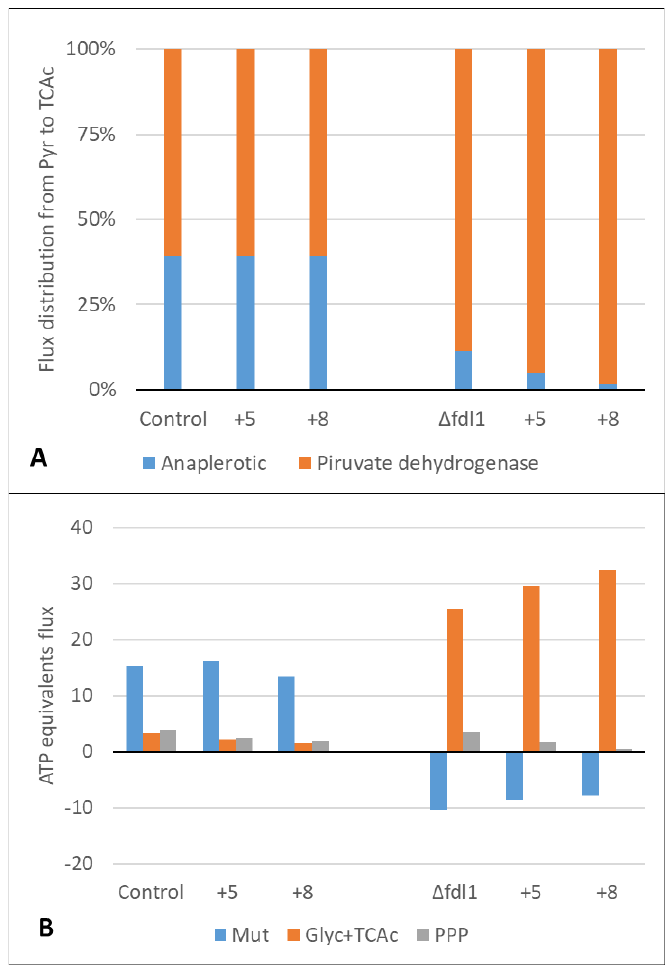
Figure 6. ( A ) Carbon flux distribution from pyruvate (Pyr) to the TCAc through the anaplerotic pathway or pyruvate dehydrogenase ( B ) Net flux of ATP equivalents flux (in mmol/g DCW · h) pro- duced (positive values) or consumed (negative values) in control and ∆ fld1 strains. Mut: methanol utilisation pathway; Glyc+TCAc: glycolysis plus TCAc; PPP: pentose phosphate